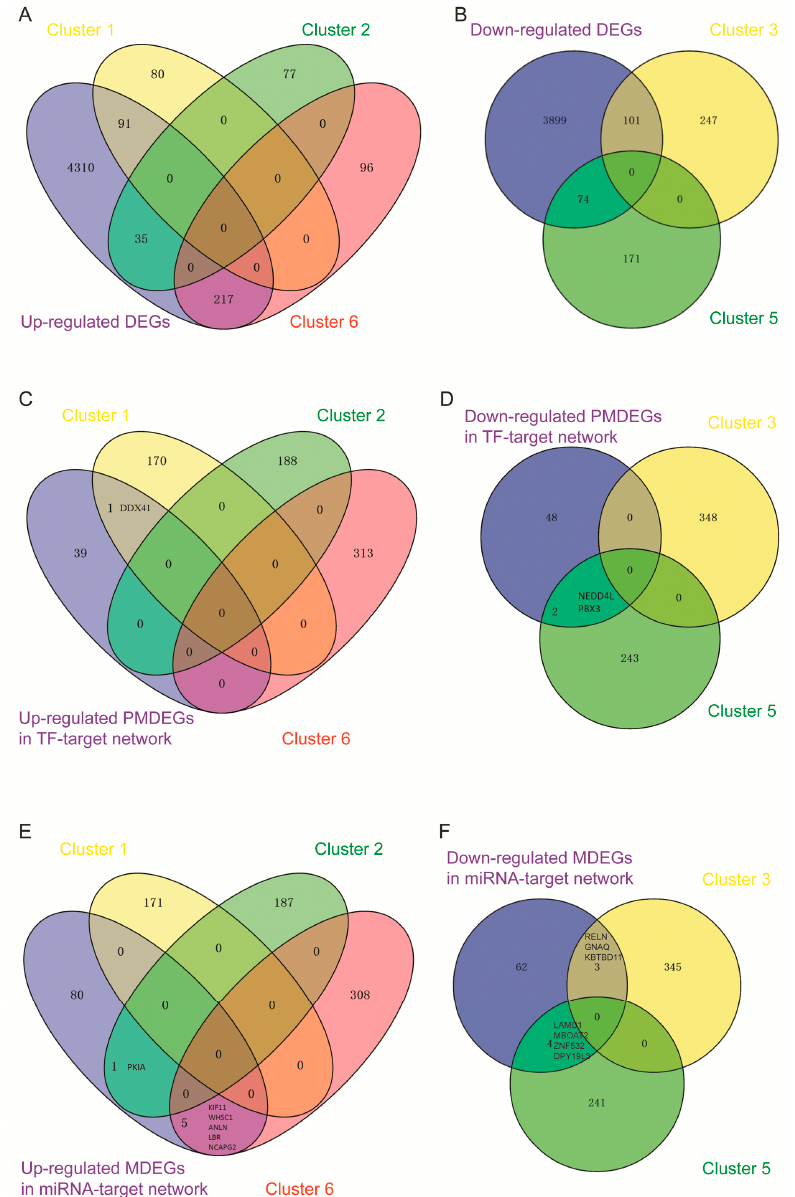
Figure 4. Comprehensive analysis of sequencing and microarray data. ( A ) Genes in clusters 1, 2, and 6 were compared with the 4653 up-regulated DEGs; ( B ) Genes in clusters 3 and 5 were compared with the 4074 down-regulated DEGs; ( C ) Genes in clusters 1, 2, and 6 were compared with the up-regulated PMDEGs in the TF-target network; ( D ) Genes in clusters 3 and 5 were compared with the down-regulated PMDEGs in the TF-target network; ( E ) Genes in clusters 1, 2, and 6 were compared with the up-regulated MDEGs in the miRNA–target network; ( F ) Genes in clusters 3 and 5 were compared with the down-regulated MDEGs in the miRNA–target network. DEGs: differentially expressed genes; TF: transcription factor; miRNA: microRNA; PMDEGs: differentially expressed genes whose promoters overlapped with DMRs; MDEGs: differentially expressed genes that overlapped with DMRs; DMRs: differentially methylated regions.